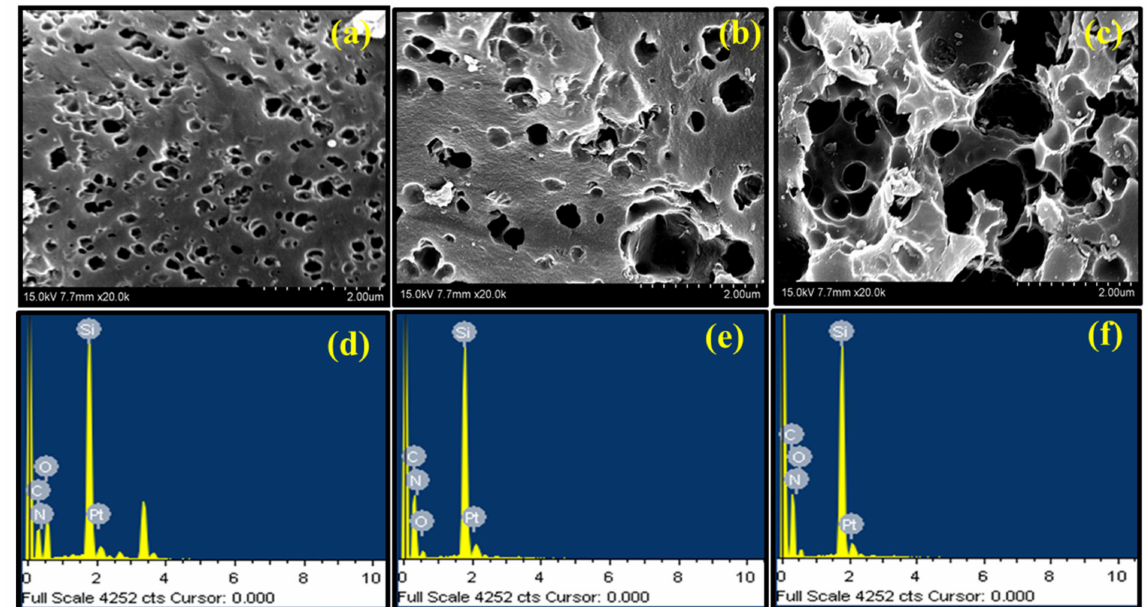
Figure 2. SEM images and EDX of ( a , d ) NRPC-700, ( b , e ) NRPC-800 and ( c , f )